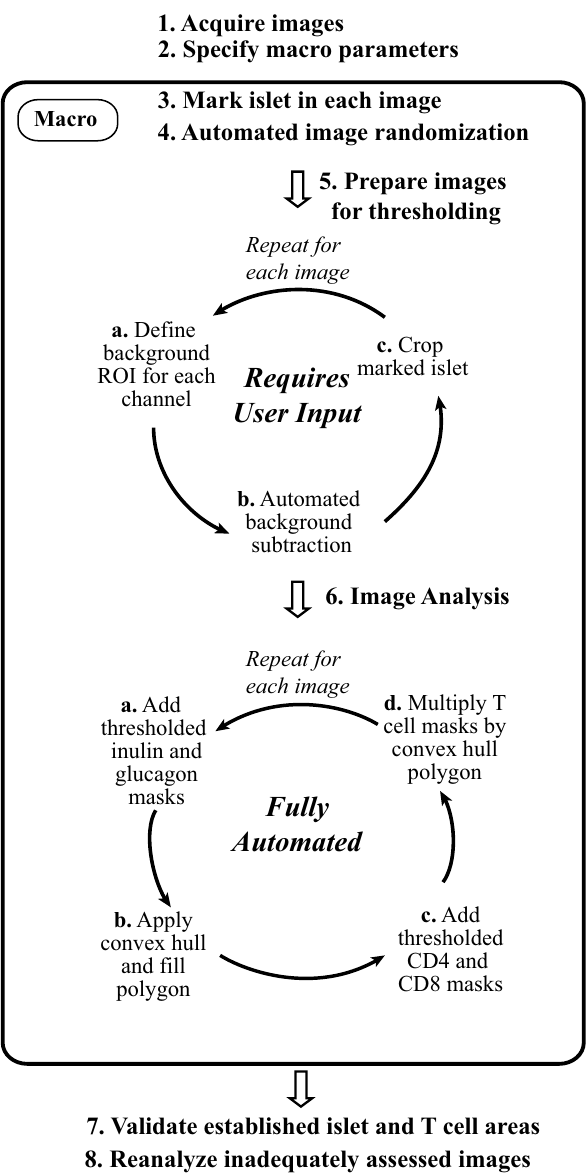
Figure 1. Quantitative imaging workflow for islet analysis. This step-by-step process integrates islet analysis using a FIJI-driven automated macro. After acquiring images and defining dataset-specific macro parameters, the FIJI macro guides the user through image randomization, background correction and cropping for each individual islet present in an image. Fully automated image analysis then proceeds to establish islet outlines by applying convex hulls to thresholded insulin and glucagon masks, and CD4 + and CD8 + T cell inflammation is quantified relative to the islet border to calculate insulitis (within islet border) and peri-insulitis (beyond islet border)